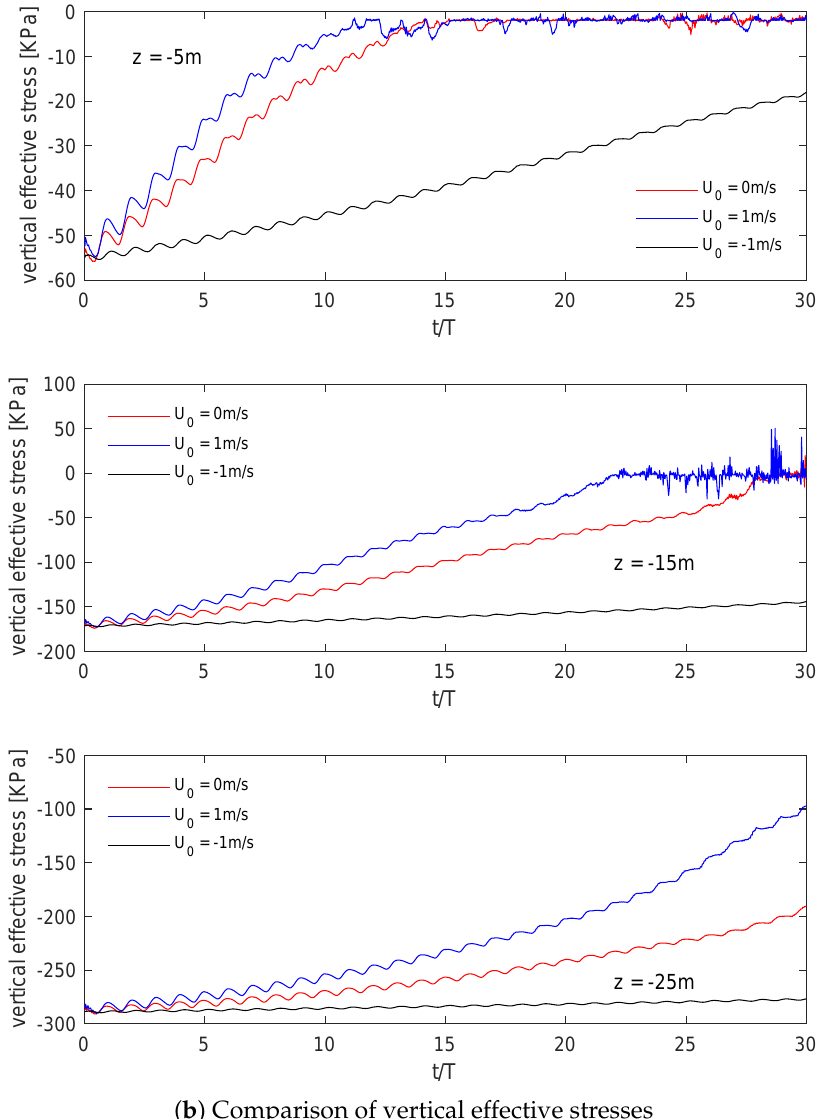
Figure 8. Cyclic response of seabed under various current conditions at different locations: ( a ) pore pressures; ( b ) vertical effective